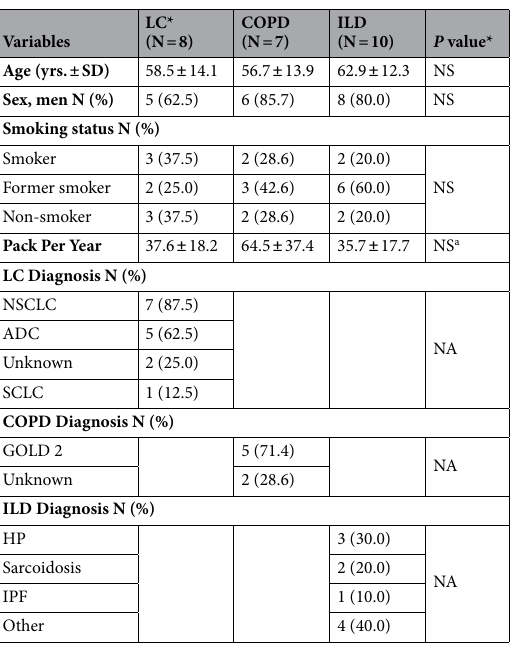
Table 2. Demographic and clinical data of the comorbidity-controlled dataset. * P values based on Kruskal– Wallis test or chi-square (normal distributed or categorical variables, respectively) for the comparison of the three groups, lung cancer (LC), chronic obstructive pulmonary disease (COPD) and interstitial lung disease (ILD). HP- Hypersensitivity pneumonitis; NS—Non-significant ( p value > 0.05); NA—Not applicable. a —results based in pairwise Welch’s t-tests.